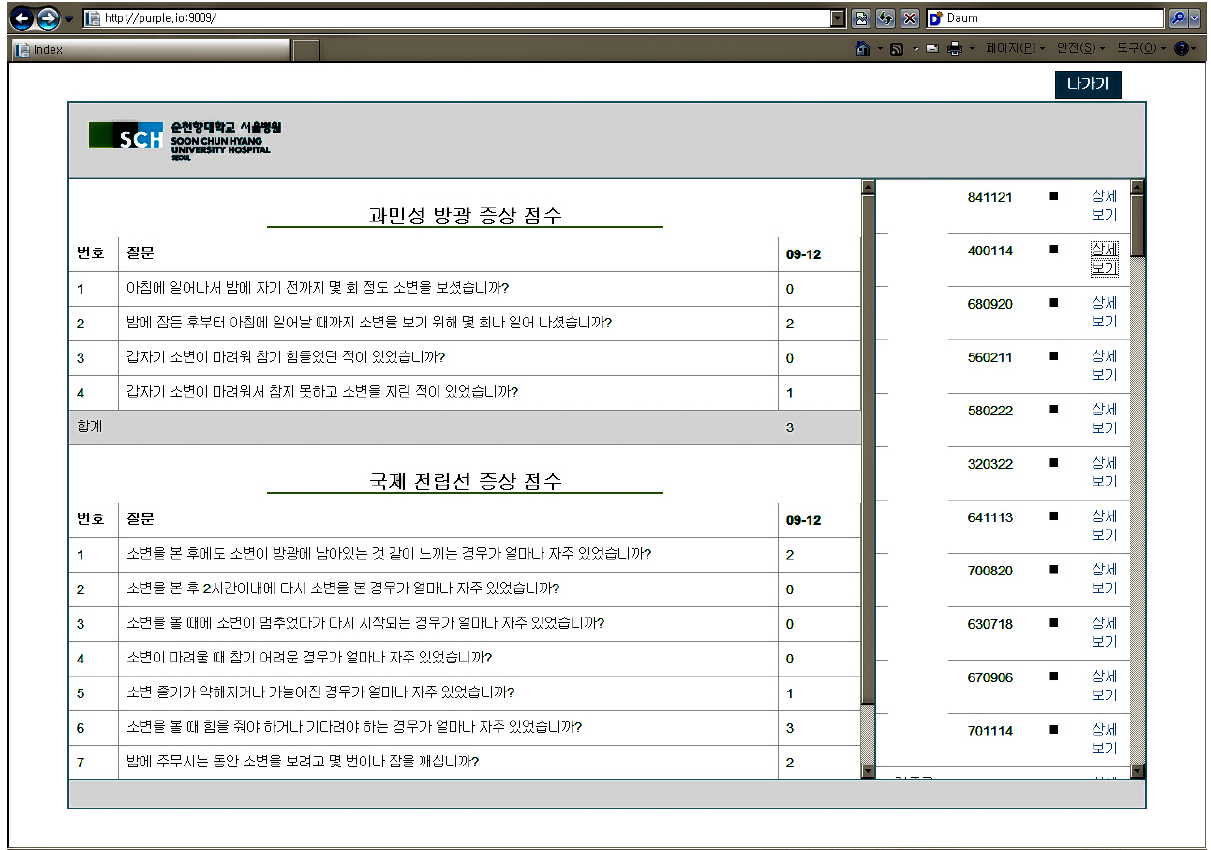
Figure 4. Registered IPSS scores are automatically transferred to main server. IPSS: International Prostate Symptom